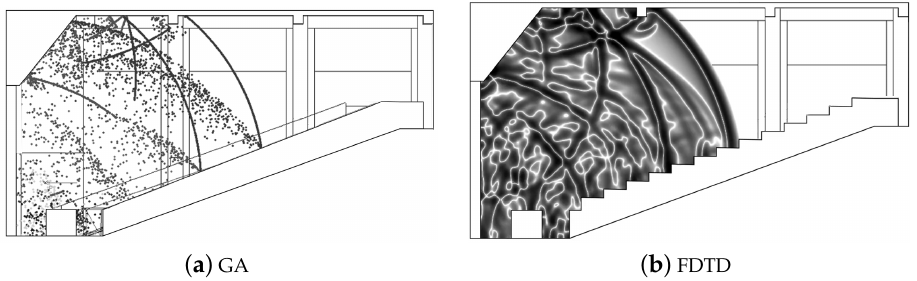
Figure 16. Qualitative visualization of sound wave propagation within the lecture hall by means of GA ( a ) and FDTD ( b ) simulations throughout the longitudinal section. The sound source is located at the teacher’s position (S1 in Figure